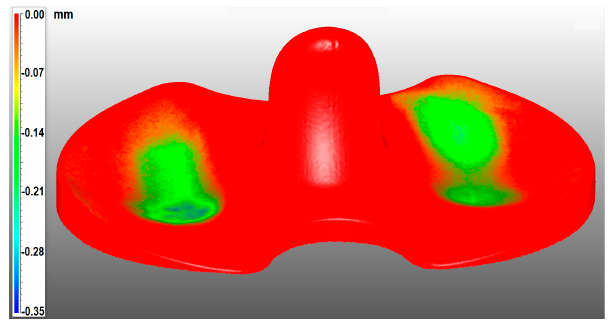
Figure 5. Tibial meniscus #2 3D wear map.